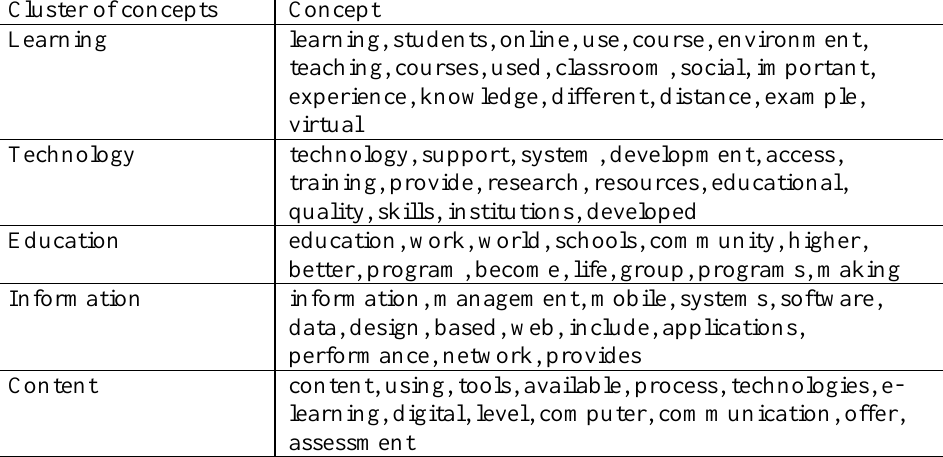
Cluster of Concepts Associated with Security in Online Learning in Blog